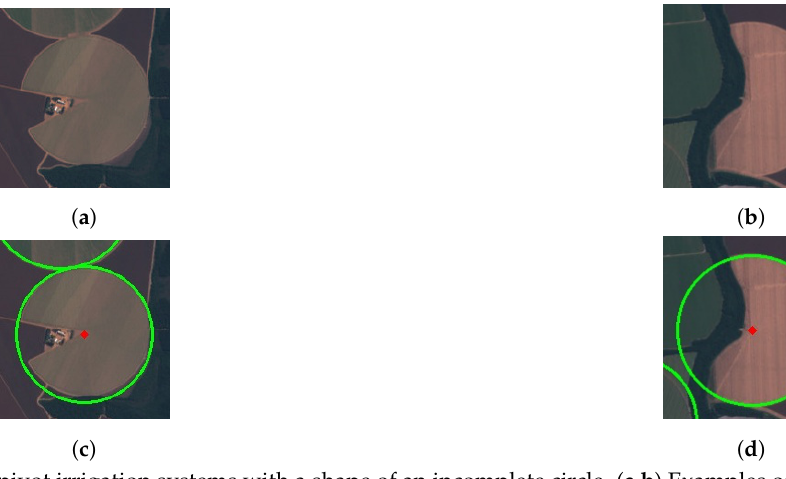
Figure 13. Center pivot irrigation systems with a shape of an incomplete circle. ( a , b ) Examples of center pivot irrigation systems with a shape of incomplete circle. ( c , d ) Detection and delineation of center pivot irrigation systems with a shape of an incomplete